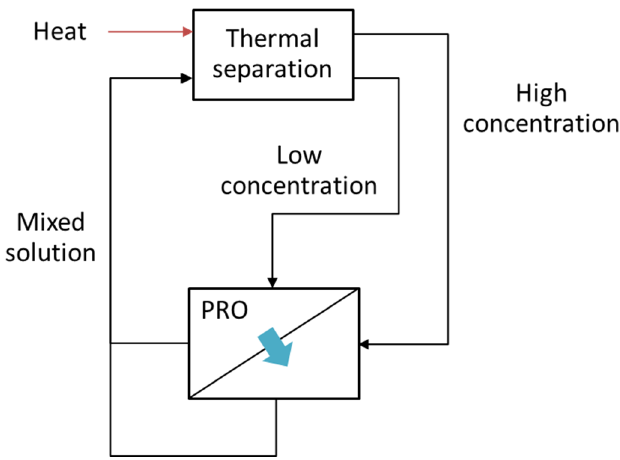
Figure 8. Schematic of osmotic heat engine, adapted from